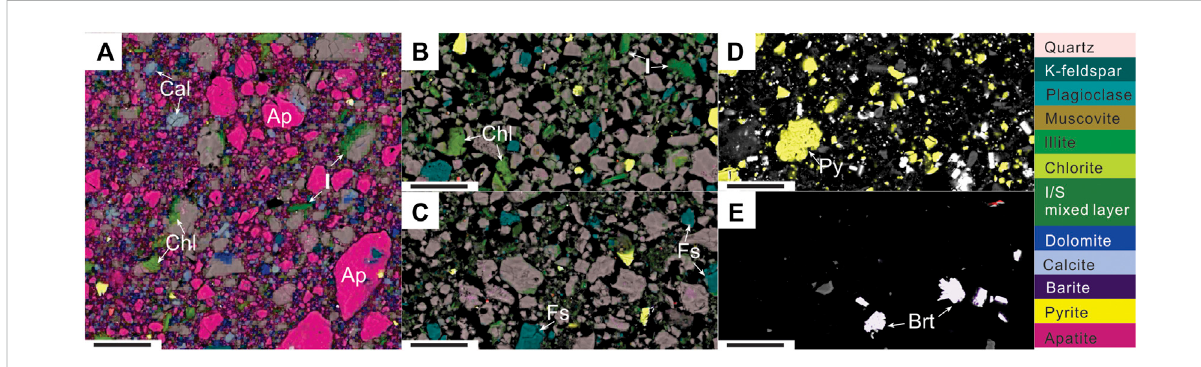
FIGURE 11 Representative petrographic images of step leaching products for Cr isotope analysis. Scale bars represent 20 μ m. In addition to the mineral legend on the right, key minerals are labeled: barite (Brt), calcite (Cal), apatite (Ap), feldspar (Fs), pyrite (Py), illite (I), and chlorite (Chl). (A) Pre-leach material; (B) samesampleaftera0.5 MHClleachwhichvisiblyremovedthehighlyreactivemineralphases,e.g.,carbonatesandphosphates; (C) after an additional 6 M HCl leach which dissolved moderately reactive mineral phases e.g., clay minerals; (D) following a third leach with HF that dissolved the bulk of silicate minerals; (E) after a fourth leach of Aqua Regia that dissolved any remaining mineral phases, but contributed to secondary barite precipitation. The visual results helped to check the target phases for geochemical analysis, con fi rming the separation of detrital and authigenic phases. The bright mineral in (E) is barite, which is very bright in the BSE image making the purple false color overlay almost